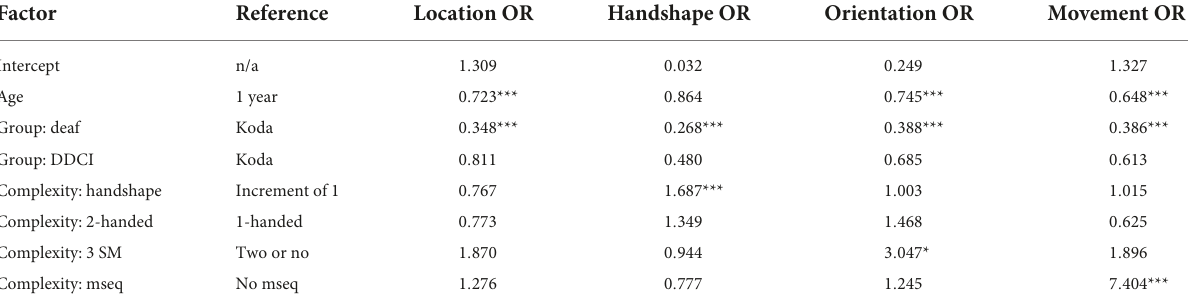
TABLE 5 Association of each parameter accuracy with age, group, and item complexity measures.